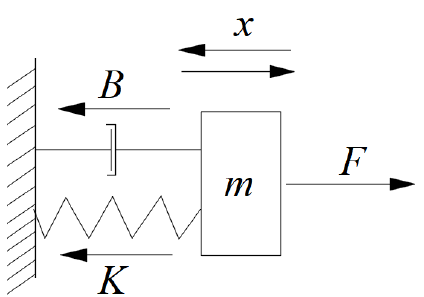
Figure 8. Header elastic damping simplified model.